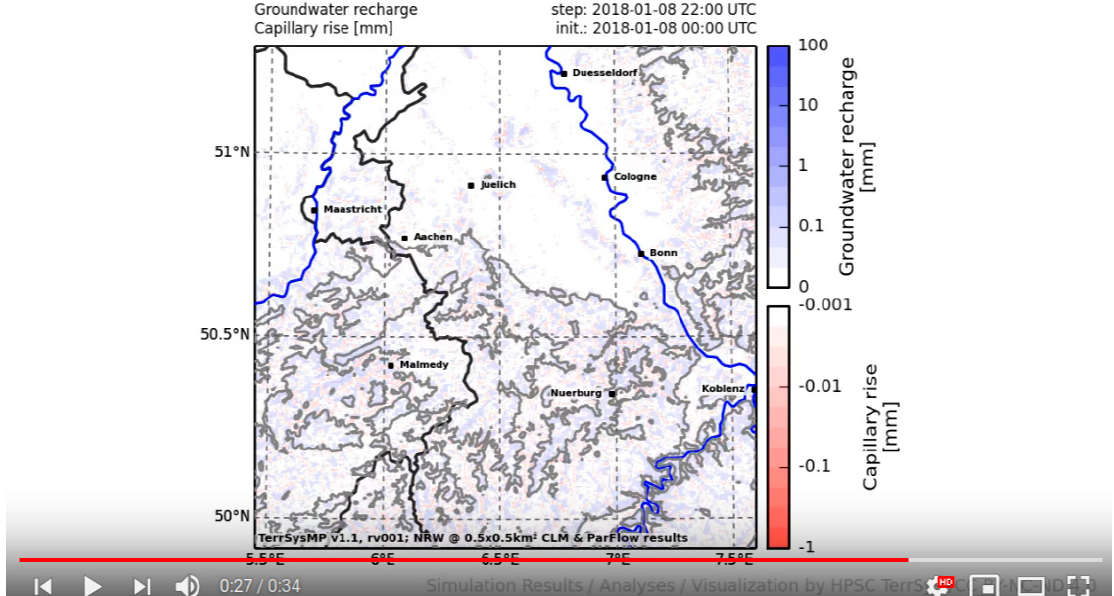
Figure 9. Monitoring output of TSMP (NRW) for groundwater recharge (positive) and capillary rise (negative) (mm) i.e. the plant available water storage change (mm (Sym. Log.)). The change is relative to the initial condition. The plant available water is the water that is stored in the pore space at a matric potential larger than − 10m.